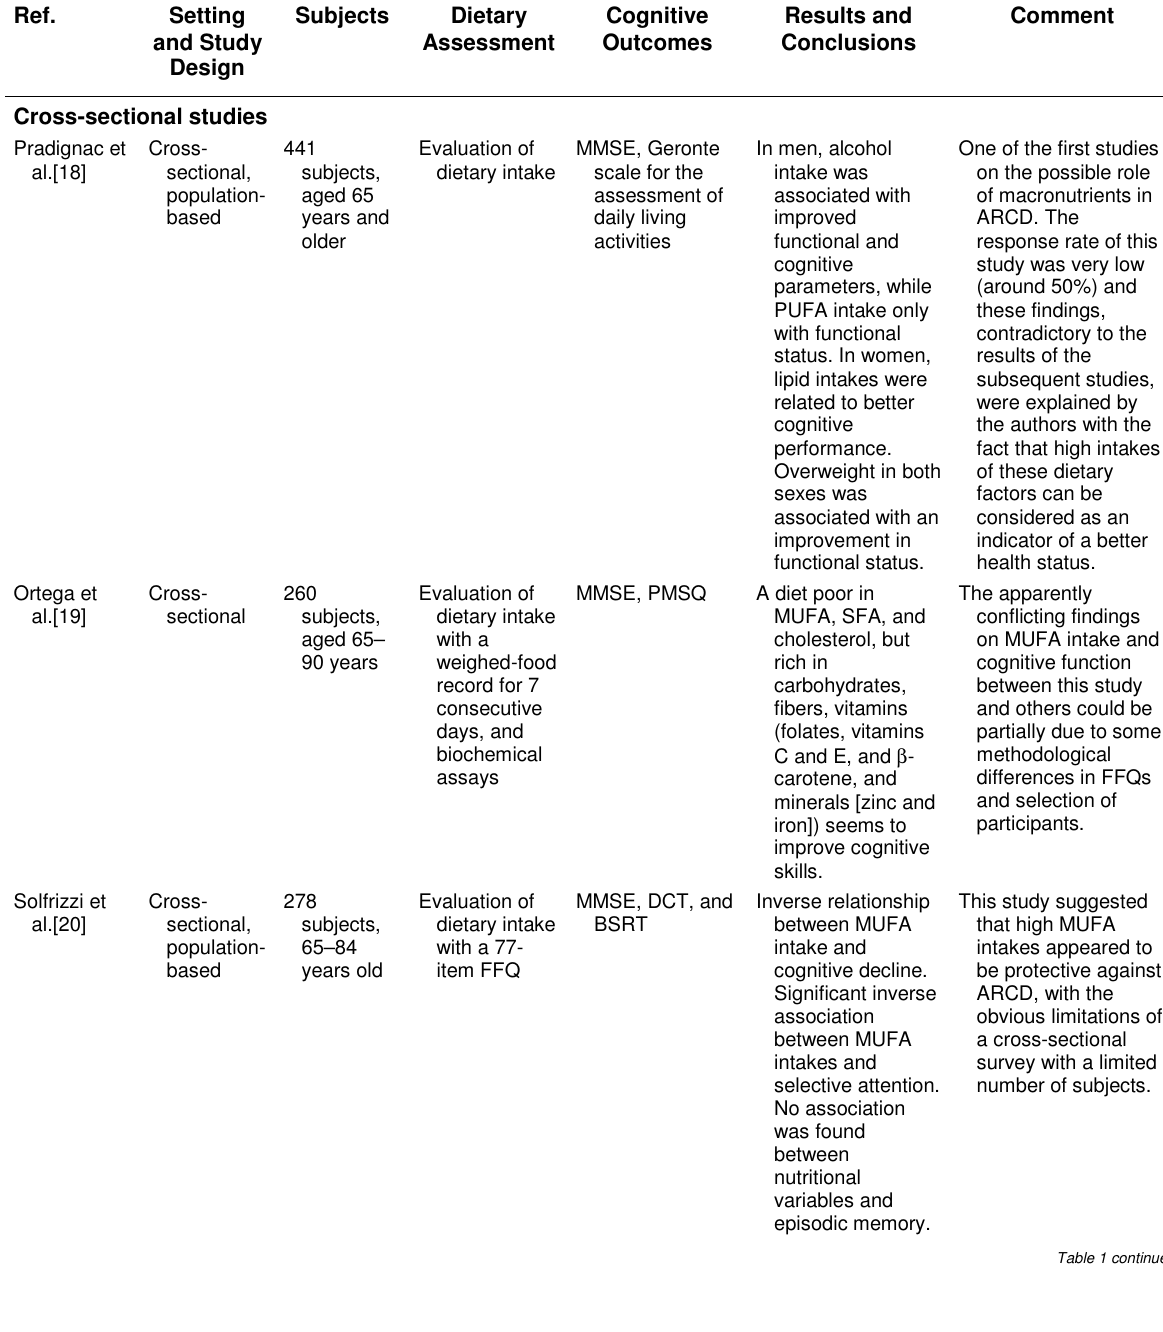
Principal Cross-Sectional and Longitudinal Clinical and Epidemiological Studies on the Relationships between Dietary Fatty Acids or Fish Consumption and Predementia